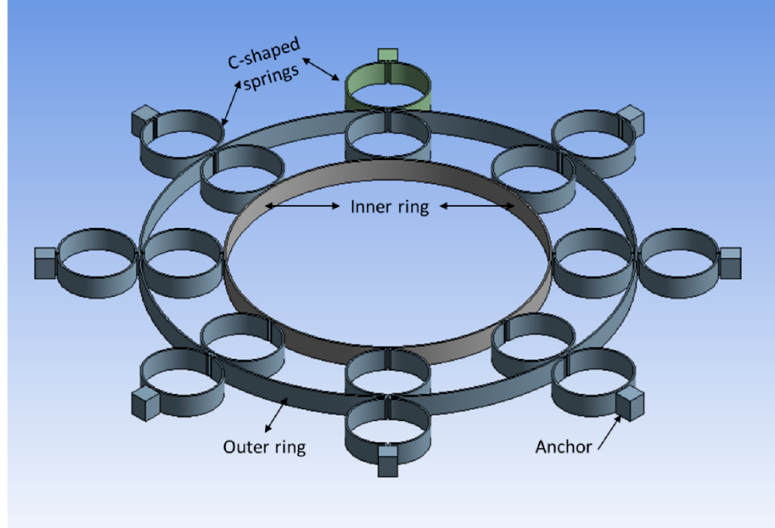
Figure 4. The design structure of a starfish-shaped MEMS vibratory ring gyroscope.